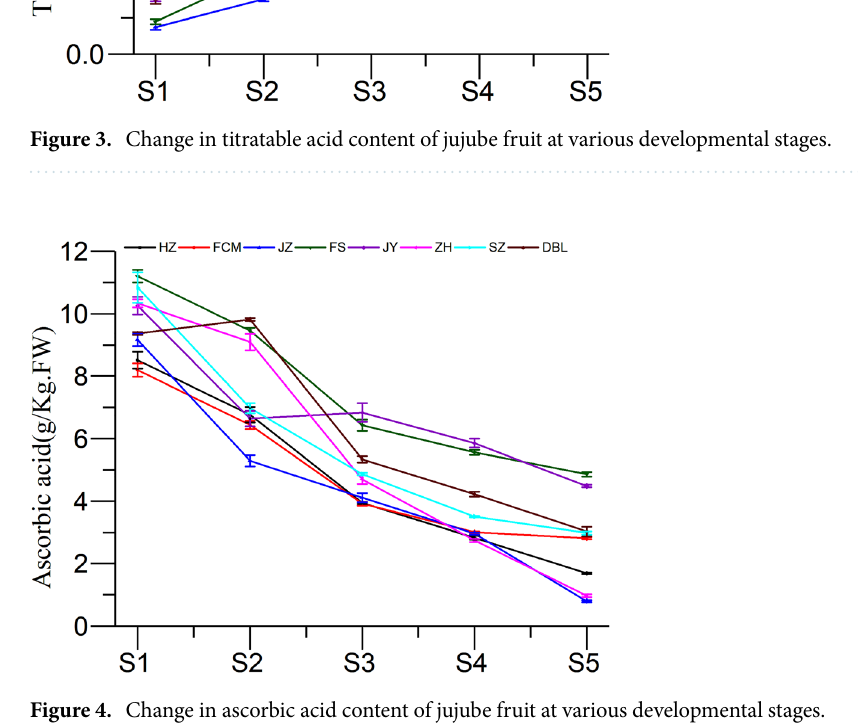
Figure 4. Change in ascorbic acid content of jujube fruit at various developmental